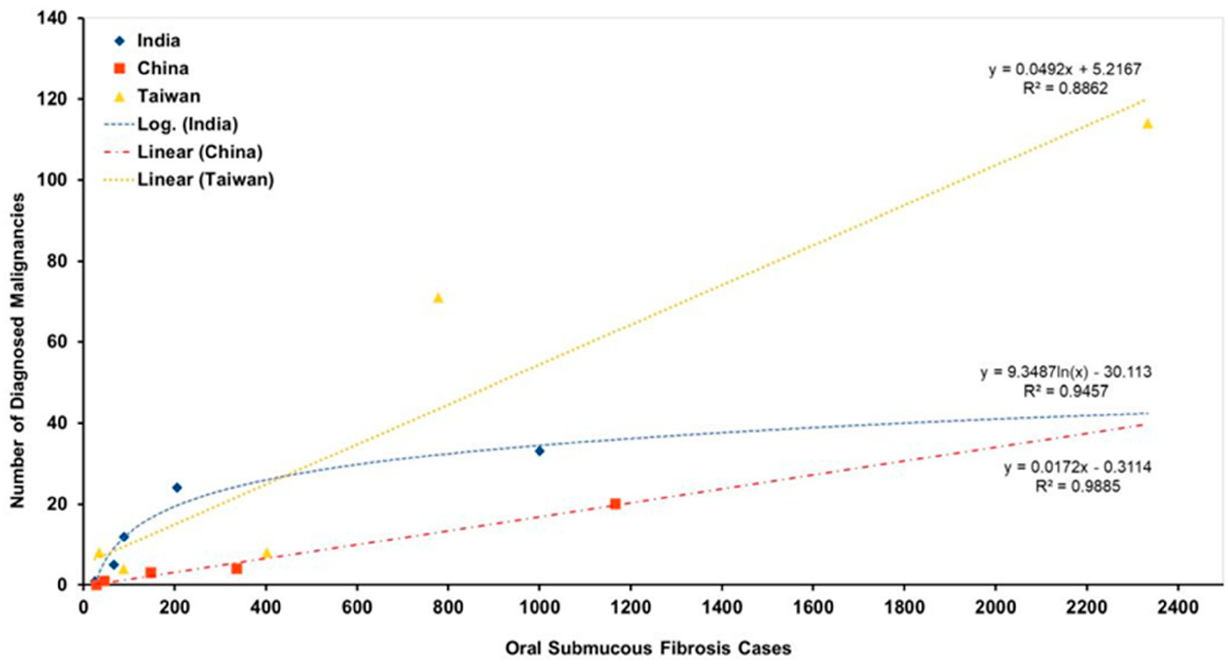
Figure 2. Comparison of cohort size and percentage of malignancies as reported per study. Logarithmic regression utilised for Indian cases and linear regression for Chinese cases.